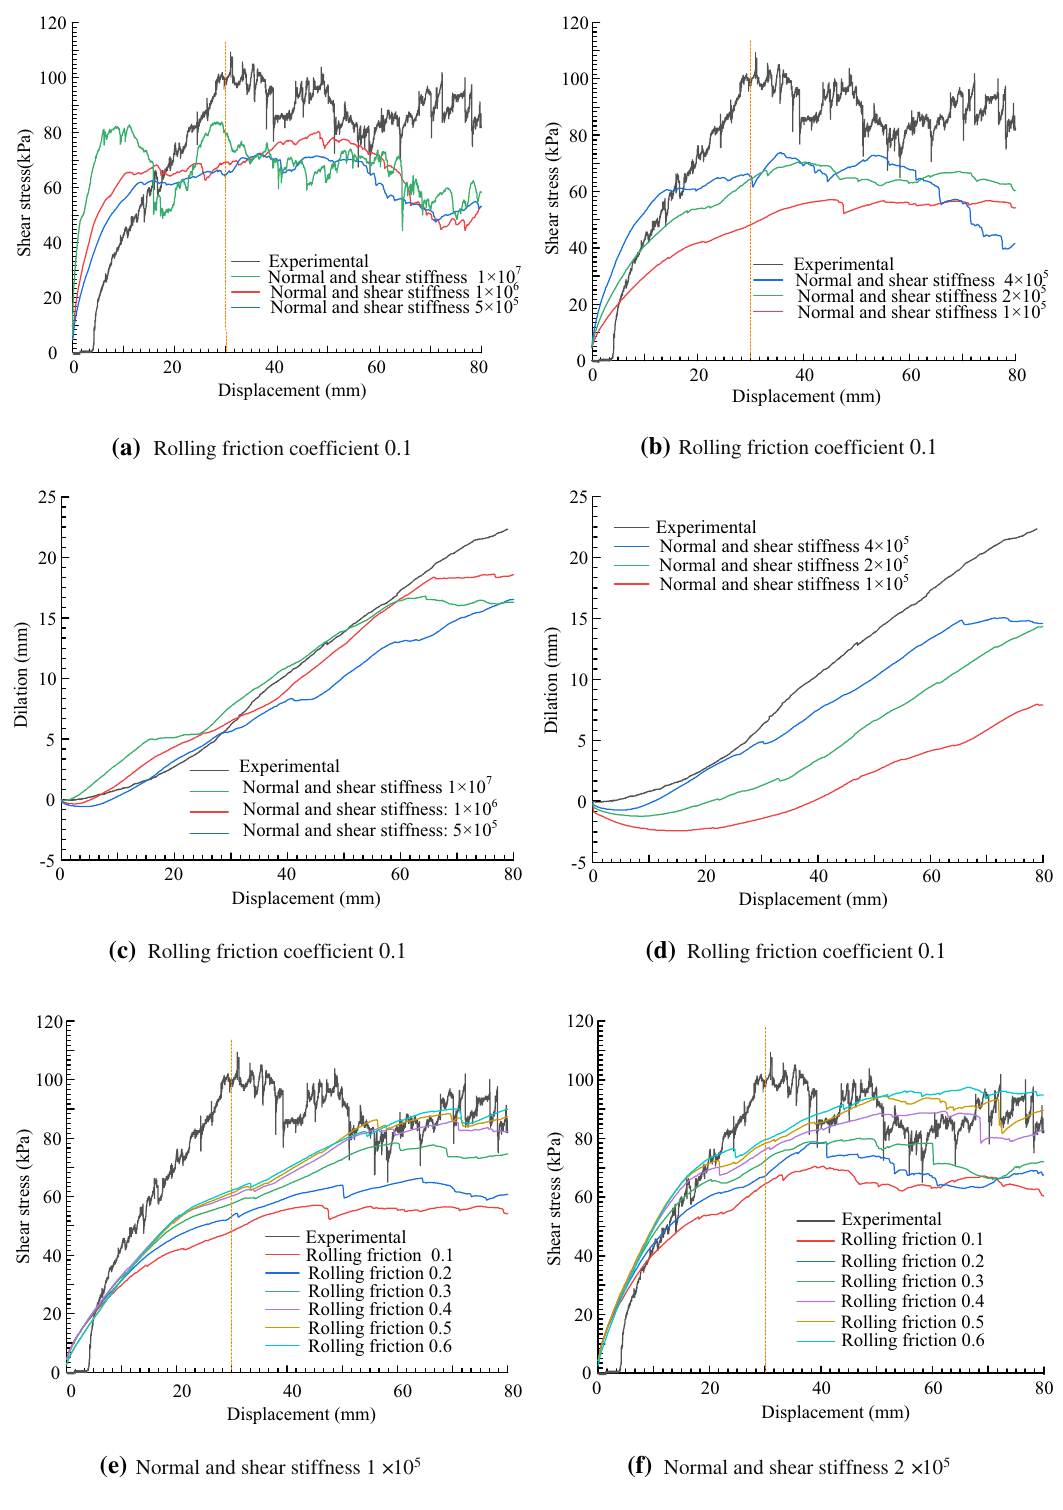
Fig. 4 Shear stress and deformation results of the DST simulation with sphere under the normal stress 24